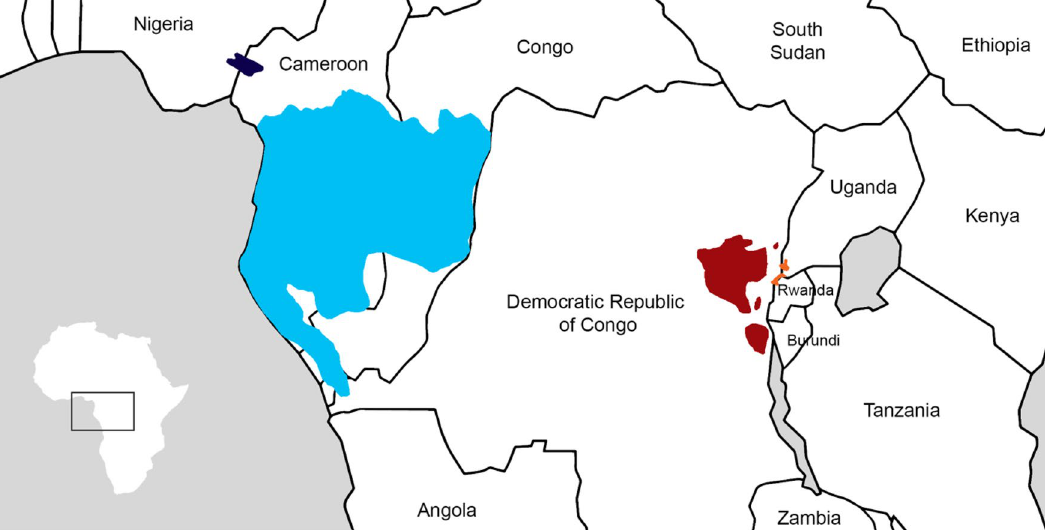
Figure 1. Map of Sub-Saharan Africa showing the distribution of western lowland gorillas ( Gorilla gorilla gorilla , in light blue), cross river gorillas ( Gorilla gorilla diehli , in dark blue), Grauer’s gorillas ( Gorilla beringei graueri , in dark red), and mountain gorillas ( Gorilla beringei beringei, in orange ). Adapted from Xue et al. 5